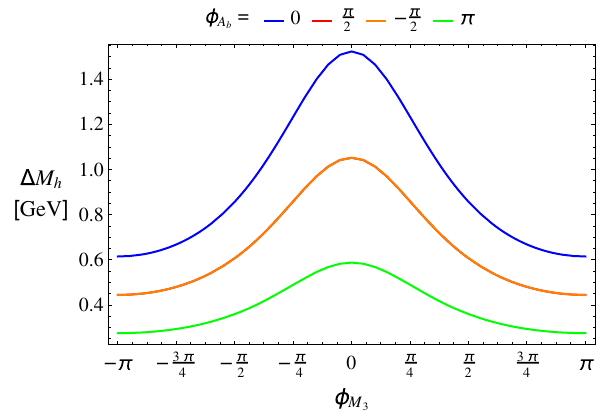
Fig. 8 Dependence of the lightest Higgs-mass shift (cid:7) M h on φ M φ